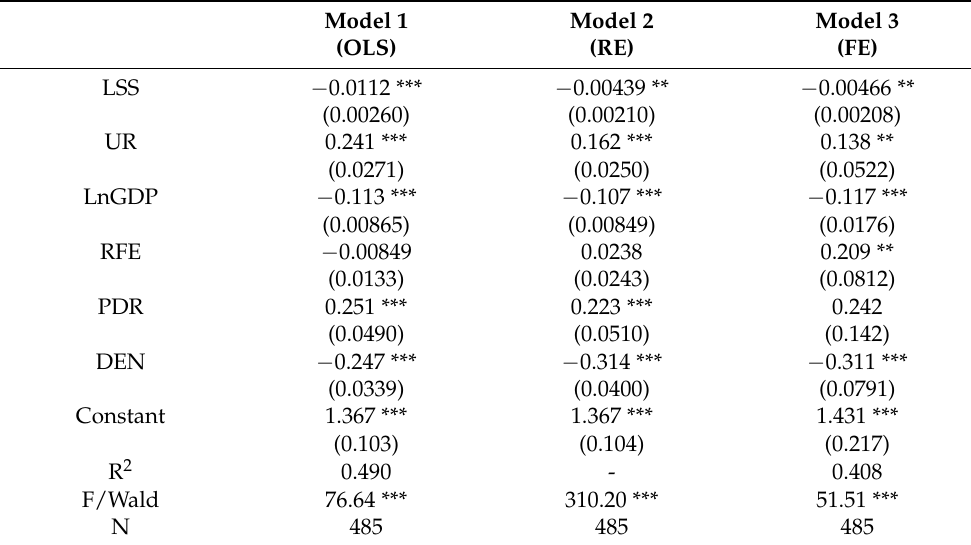
Table 3. Land supply structure and consumption